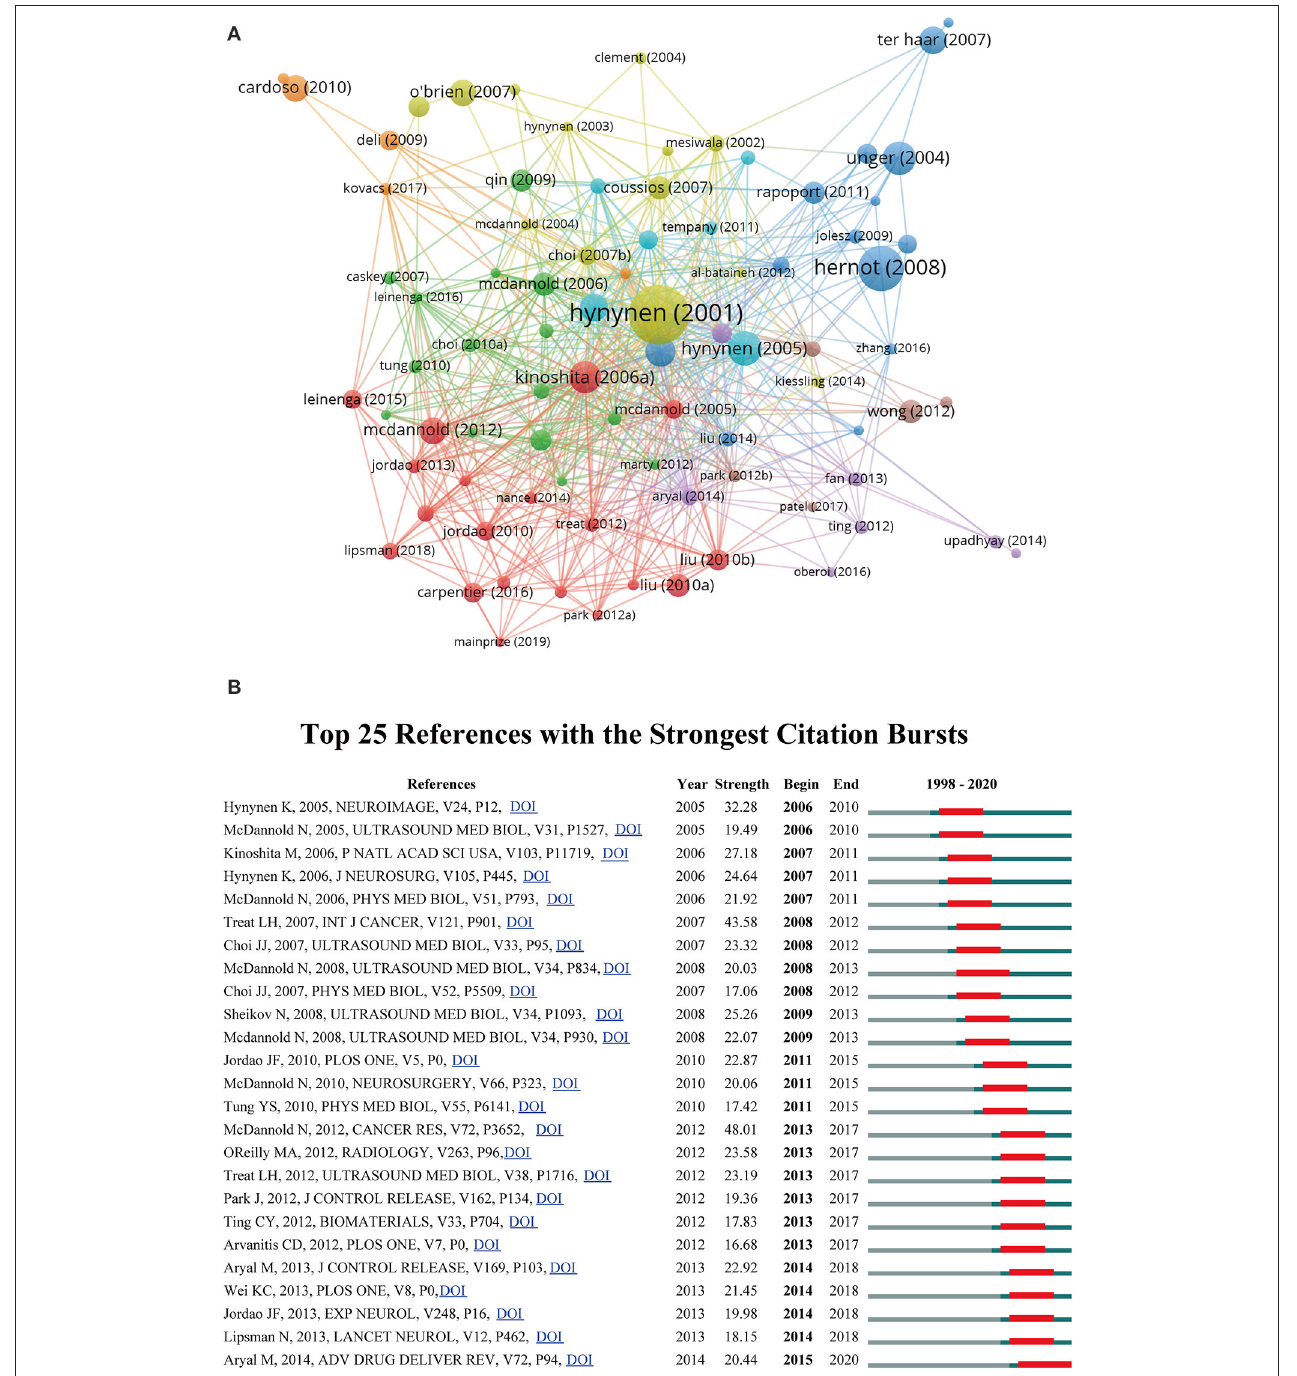
FIGURE 7 | (A) Co-citation network visualization map of references generated by VOS viewer. (B) The top 25 references with the strongest citation bursts from 1998 to 2020.